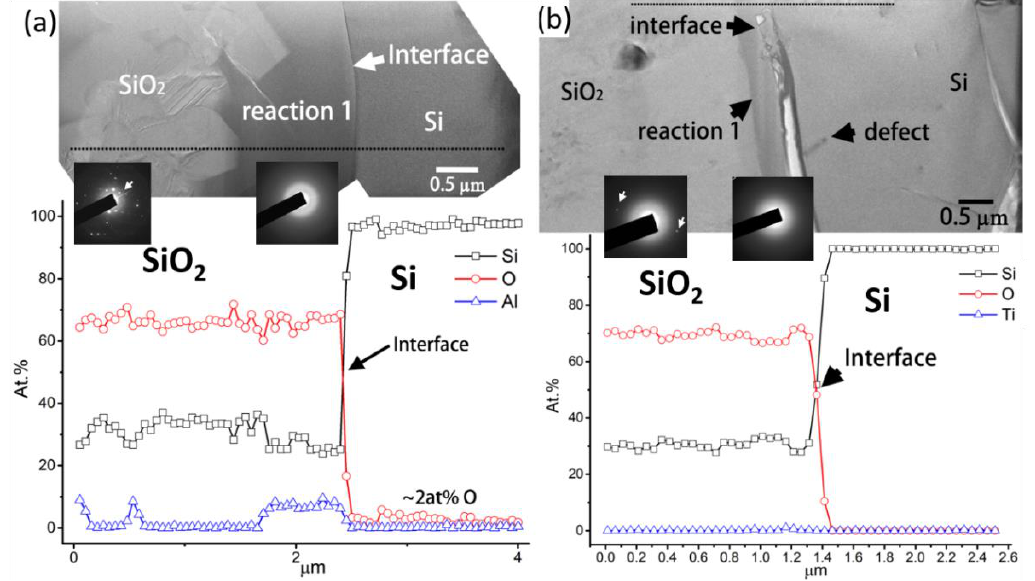
Figure 9. BFIs/TEM images, EDS line scans, and SADPs of ( a ) Si/SiO 2 – 10 wt.% Al 2 O 3 and ( b ) Si/SiO 2 – 10 wt.% TiO 2 interfaces.